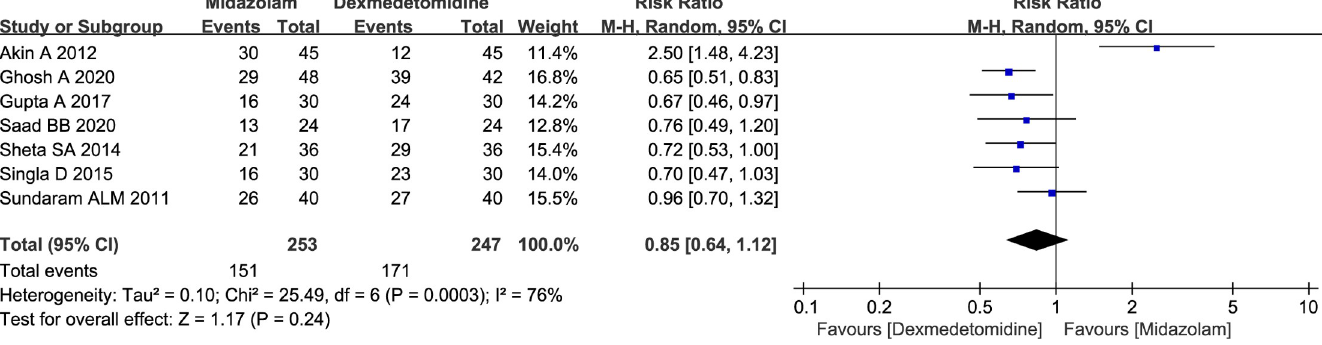
PLOS ONE | https://doi.org/10.1371/journal.pone.0281751 February 14,